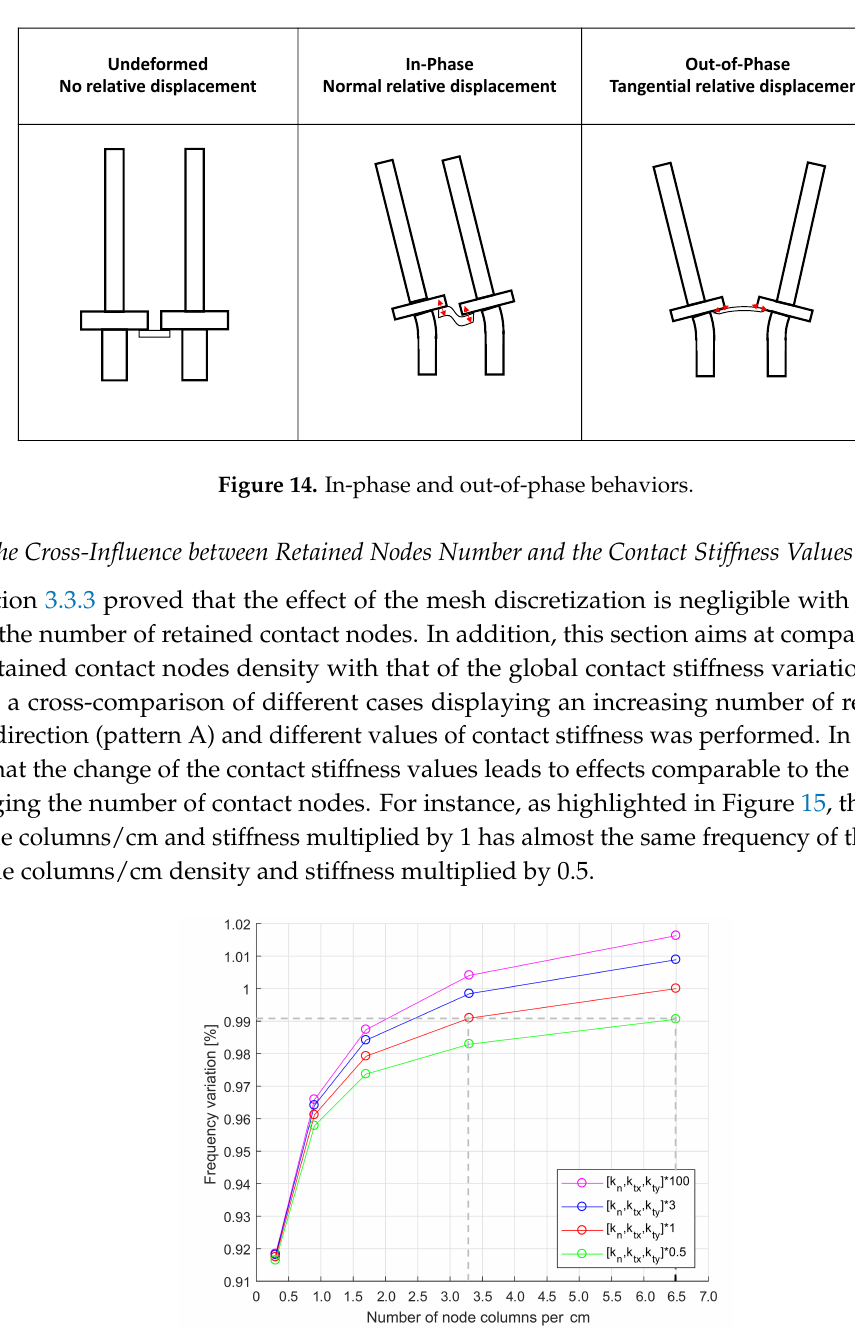
Figure 15. Natural frequency versus the number of retained nodes for different contact stiffness